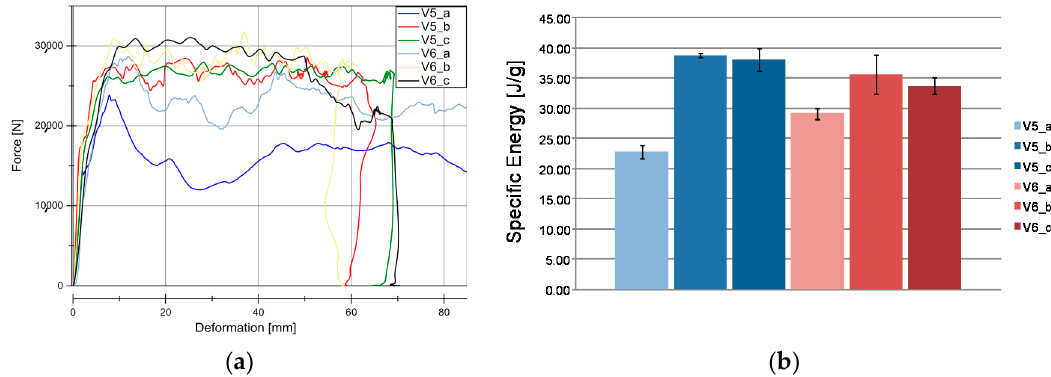
Figure 14. Results for V5 and V6 materials. ( a ) Load-Deformation curve for V5 and V6 materials under different velocities rates under crash tests conditions. ( b ) SEA evaluation in V5 and V6 series (Twill/PLA and Hopsack/PLA weave type evaluation).